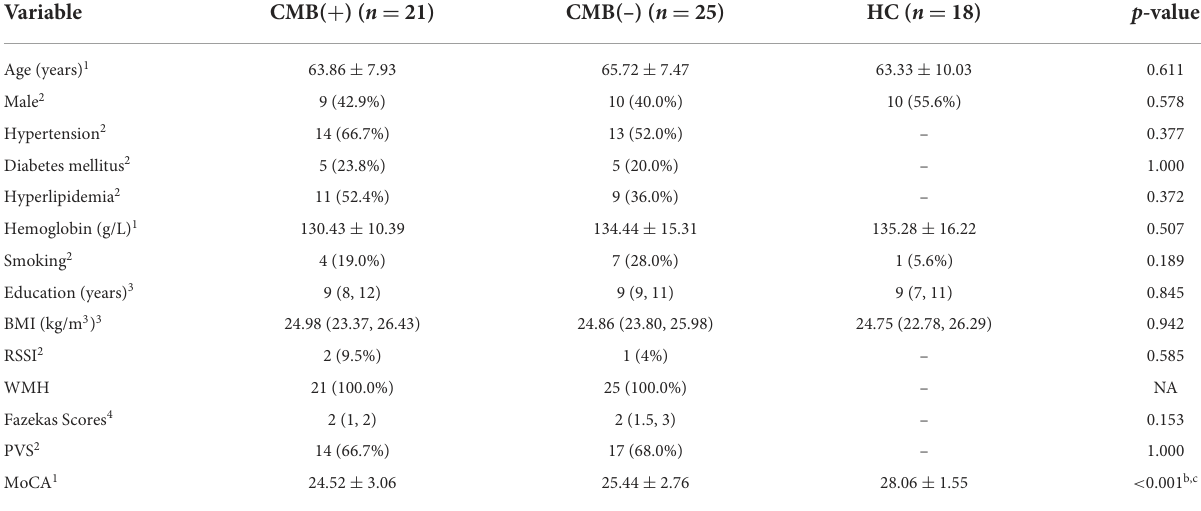
TABLE 1 The characteristics of participants with or without CMB.